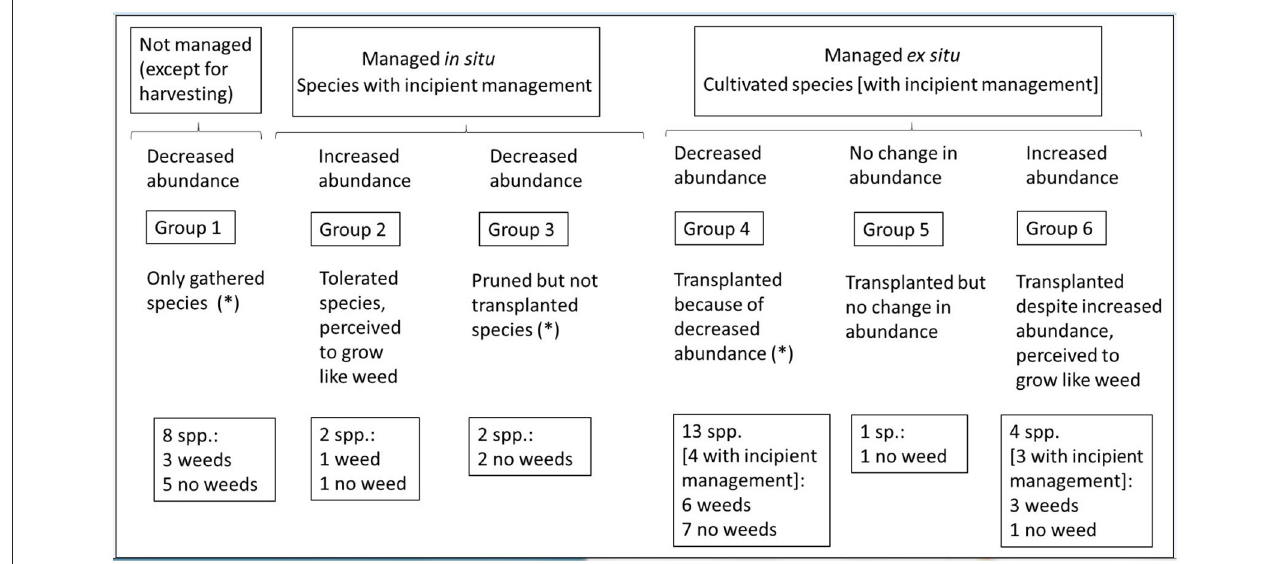
FIGURE 5 | Groups of “wild” food plant species according to management and local perceptions ( n =